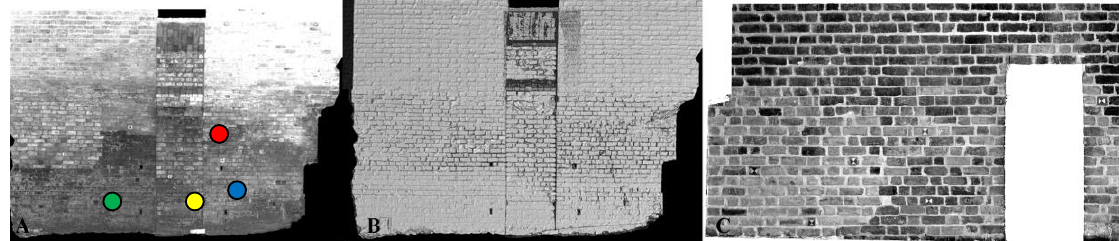
Figure 11. Example A) orthoimage in the intensity of outer wall of the Justice Court Tower with dating marked (Table 3), B) Shaded digital object model, c) orthoimage of the intensity of one of the walls in the Prison